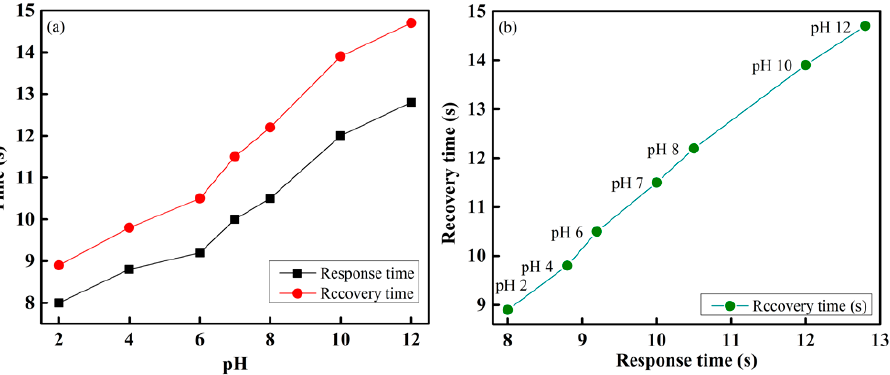
Figure 11. Performance of the fiber-optic PWM pH-sensing system: ( a ) response and recovery times; and ( b ) response versus recovery times of different pH of buffer solution.